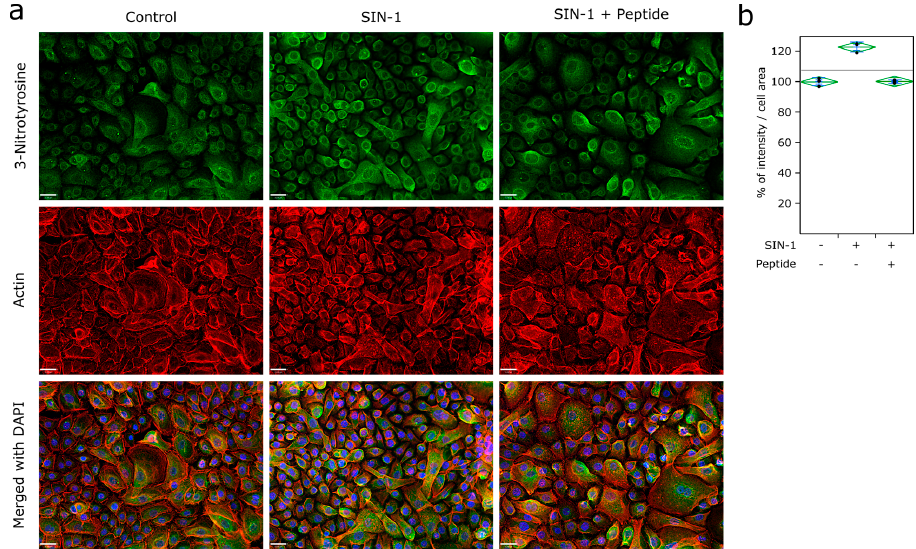
Figure 8. Ubiad1 modulation limits protein nitration by reactive nitric species. ( a ) Immunodetection of 3-nitrotyrosine (green), F-actin staining with phalloidin (red) and DNA stained with DAPI (blue) in keratinocyte submitted to reactive nitric species stress (×20 objective lens, scale bar = 31 µm); ( b ) 3-nitrotyrosine quantification graph with One-Way Analysis of Variance, displaying confidence interval means diamonds (green). The line across each diamond represents the group mean. The vertical span of each diamond represents the 95% confidence interval for each group. Grand sample mean is represented by a horizontal black